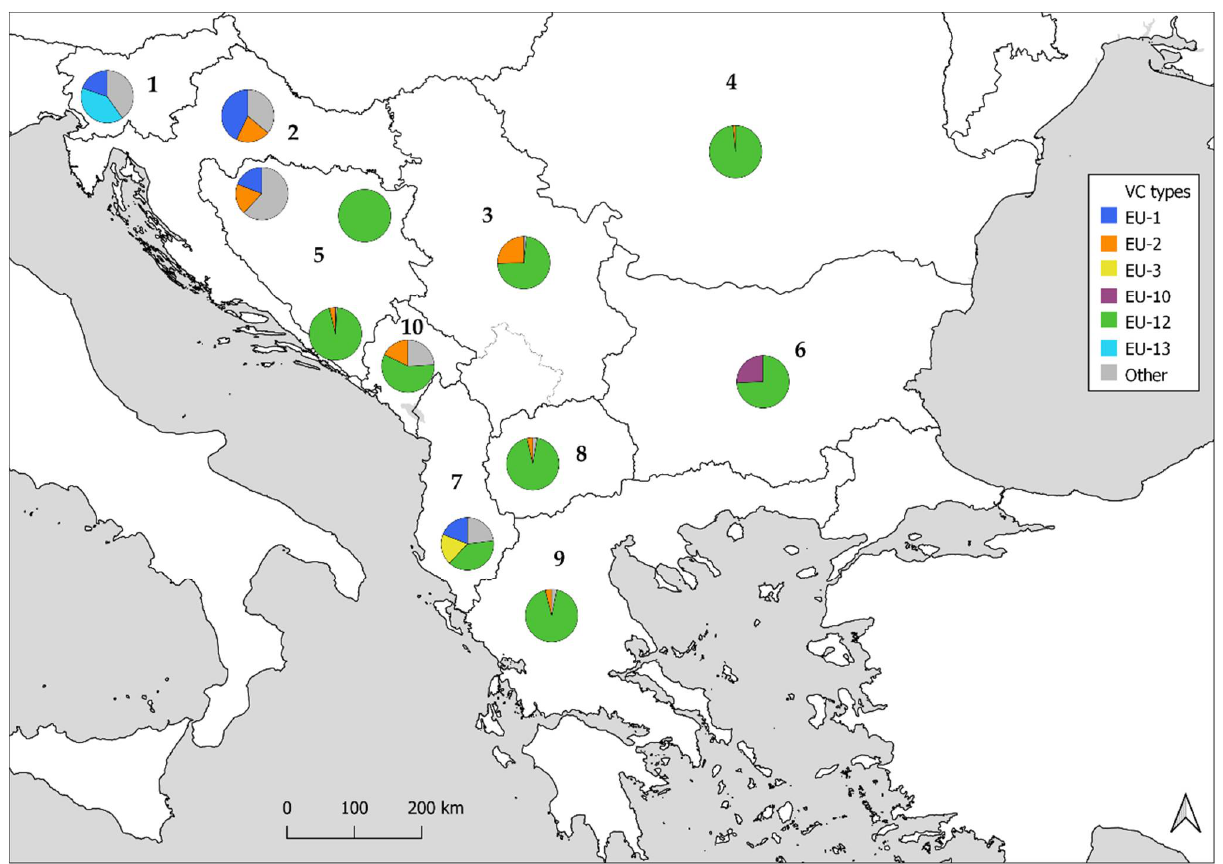
Figure 4. Two most abundant vegetative compatibility (vc) types of Cryphonectria parasitica in different countries on Balkan Peninsula, based on previously published data for Slovenia (1) [33], Croatia (2) [44], Serbia (3) [42], Romania (4) [19,47,48], Bosnia and Herzegovina (5) [45], Bulgaria (6) [47], Albania (7) [43], North Macedonia (8) [46], and Greece (9) [21,46], and data from this research for Montenegro (10).